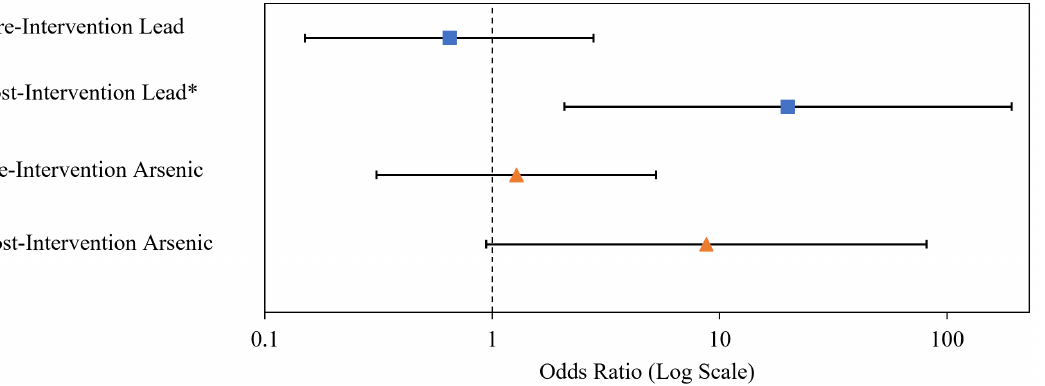
Figure 9. Odds ratios between the soil concentration category of arsenic and lead (above or below the EPA action level) and soil quality perception category (negative or positive) as reported by subjects before and after receiving information on the metal concentrations in their yard ( n = 35). * The association was significant at the alpha = 0.05 level.